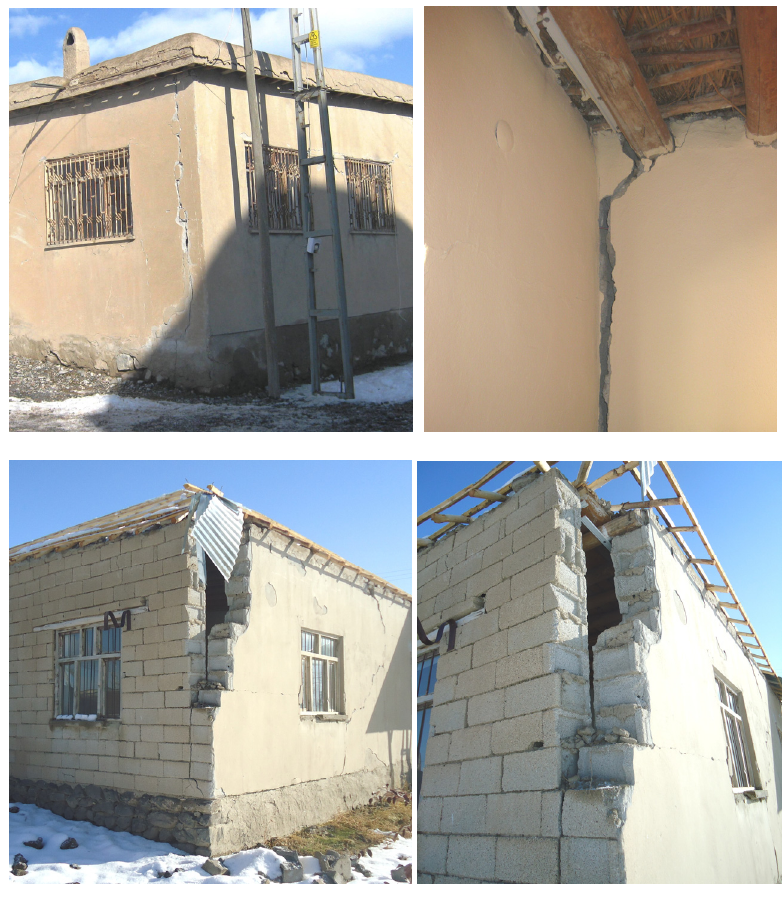
Fig. 9. Damages observed at intersection of outer walls.